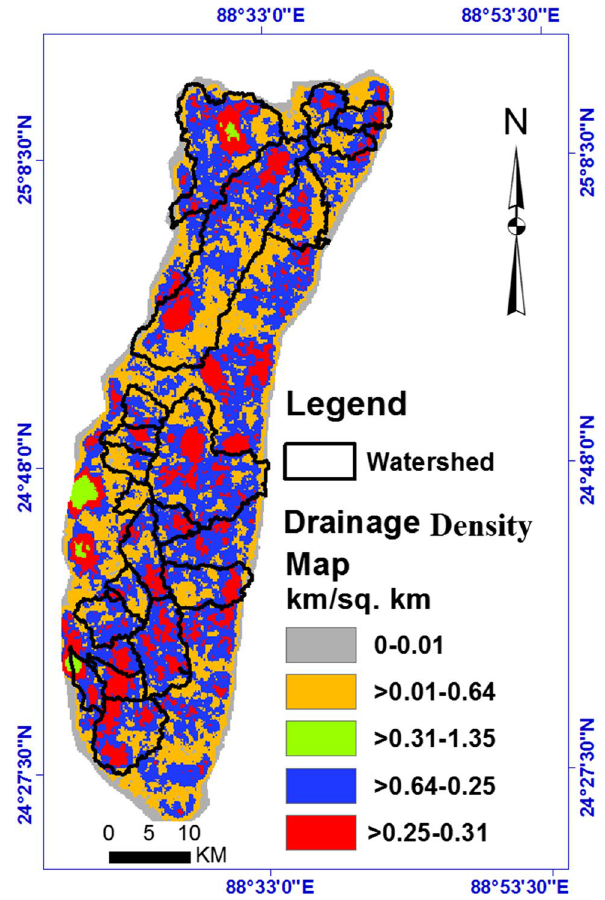
Fig. 8 Drainage density of the proposed